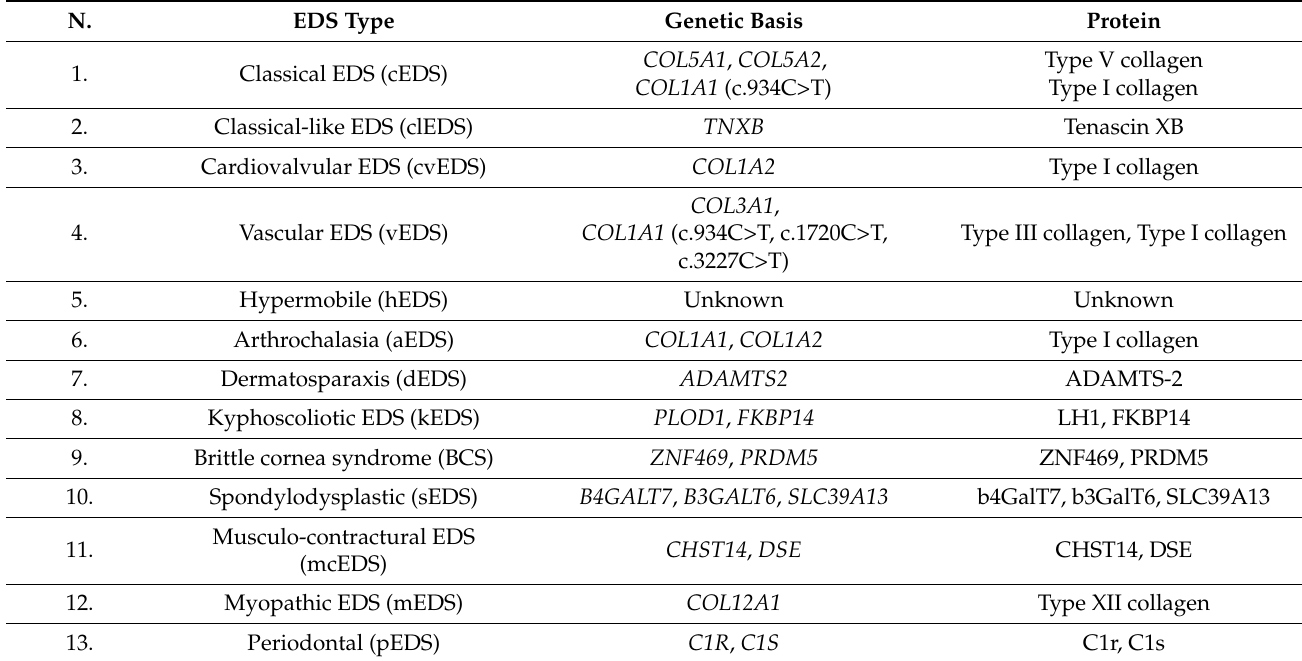
Table 1. The 2017 International Classification of Ehlers-Danlos Syndrome